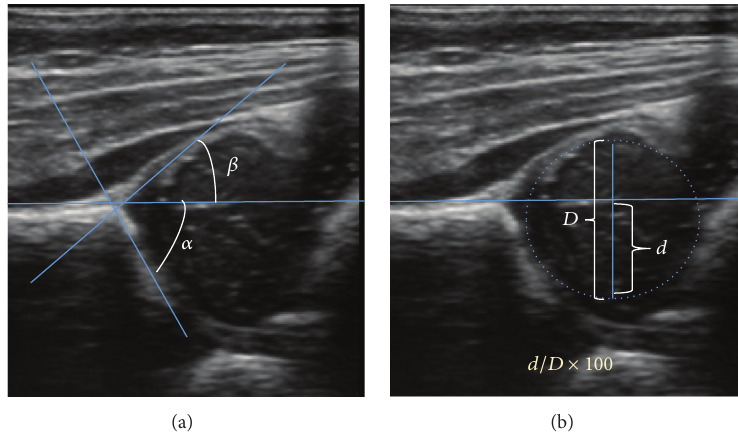
Figure 11: (a) Useful ultrasound measures in neonatal hip sonography, alpha and beta angles. (b) Measurement of femoral head coverage.